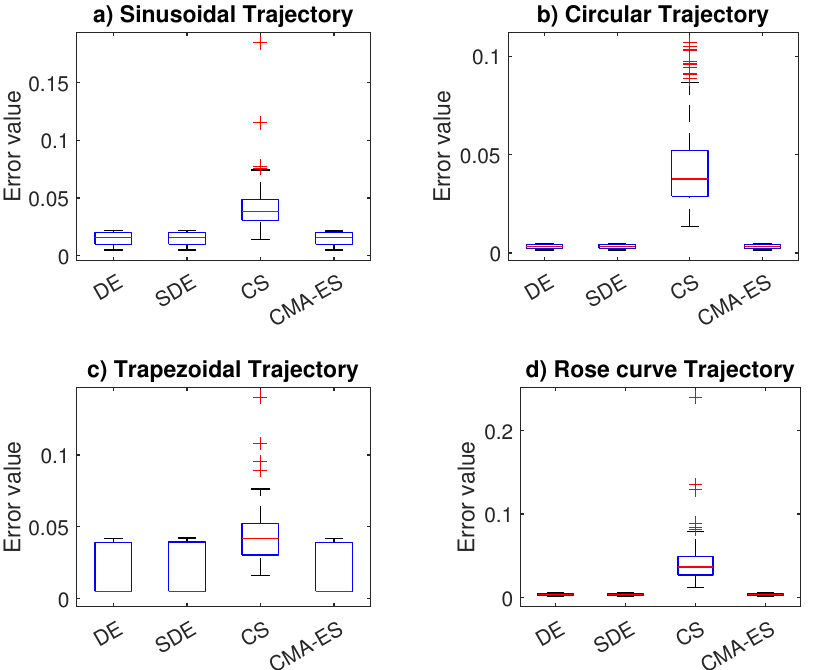
Figure 9. Motion error results of coordinated trajectory tracking